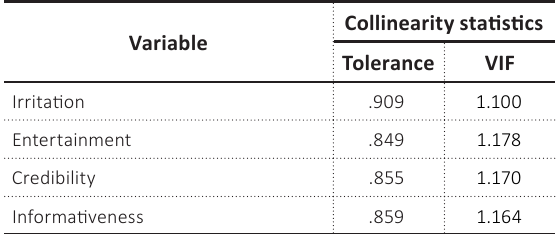
Table 9. Collinearity statistics results